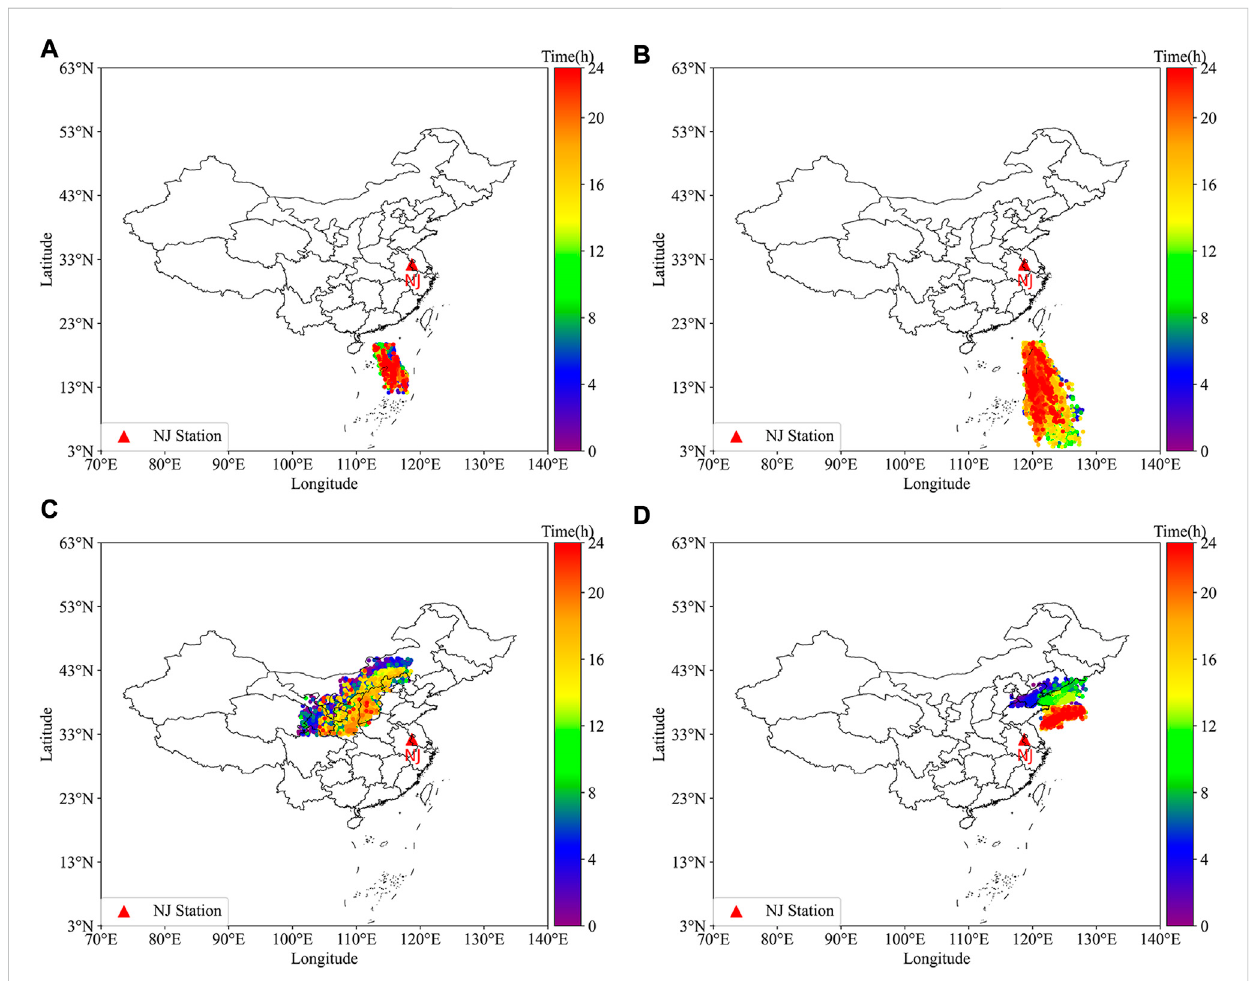
FIGURE 1 The distribution of lightning events in selected regions (A) From 00:00 to 23:59 on 11 August2022 (local time); (B) From 00:00 to 23:59 on 13 August2022 (local time); (C) From 00:00 to 23:59 on 14 August2022 (local time); (D) From 00:00 to 23:59 on 15 August2022 (local